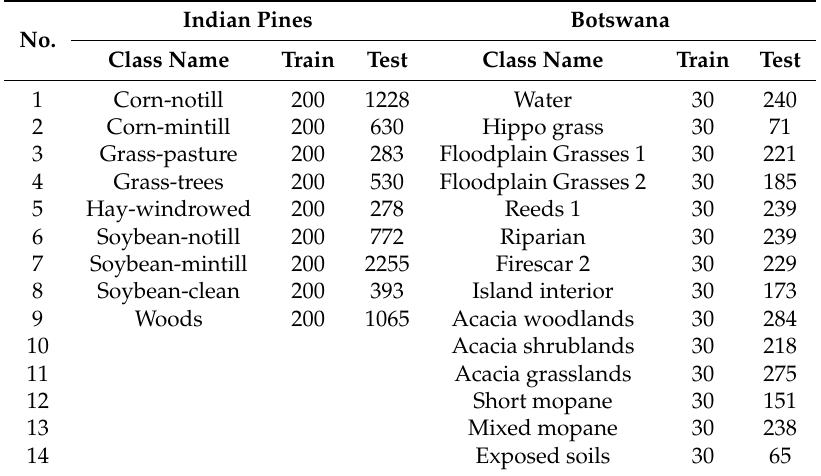
Table 3. The number of training and test samples used in Indiana Pines and Botswana datasets.